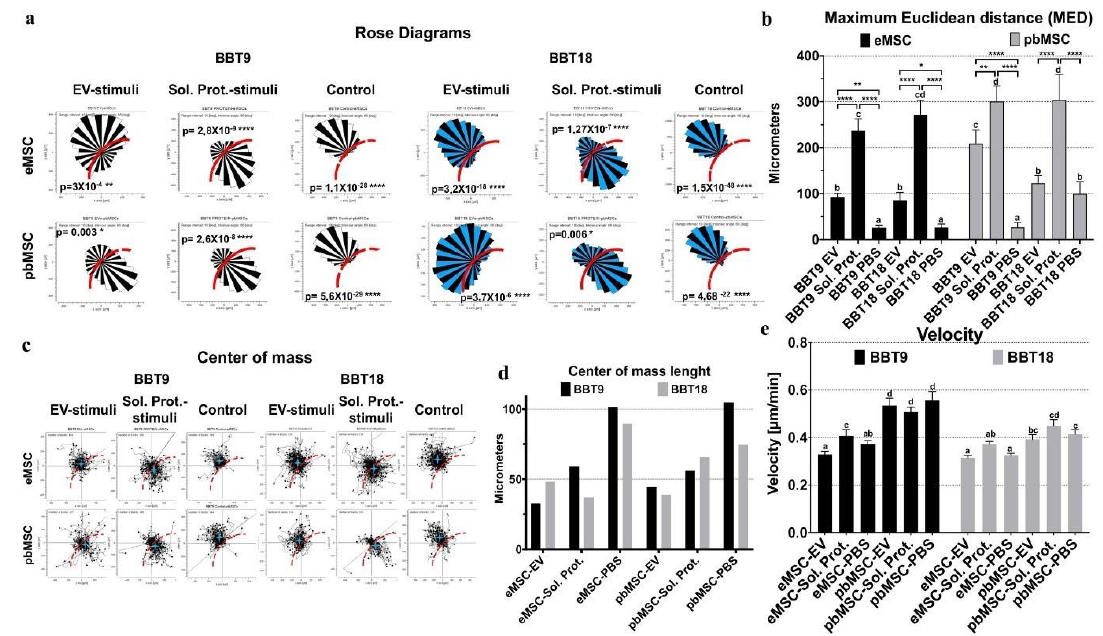
Figure 4. Maternal MSCs show chemotactic migration to BBT-9- or BBT-18-secretome. Analysis of the chemotactic effect on rose diagrams of eMSC and pbMSC without stimuli (control) or stimulated by EVs or soluble proteins from BBT-9- or BBT-18-secretome ( a ). The maximum Euclidean distance (MED) of eMSC or pbMSC towards EVs or soluble proteins from BBT-9 or BBT-18 was measured (mean ± SD). Different letters indicate a significant difference. * p < 0.05; ** p < 0.005; **** p < 0.0001. ( b ). The center of mass (COM): a strong chemotactic migration parameter for the analysis of the migrating response of eMSC and pbMSC towards EVs or soluble proteins from BBT-9 or BBT-18. Charts showing the trajectory plots marking each cell track with its endpoint ( c ), or the center of mass length ( d ), of eMSC and pbMSC without stimuli (control) or stimulated by EVs or soluble proteins from BBT-9 or BBT-18. The velocity of eMSC or pbMSC towards EVs or soluble proteins from BBT-9 or BBT-18 was measured (mean ± SD). Different letters indicate a significant difference ( e ).